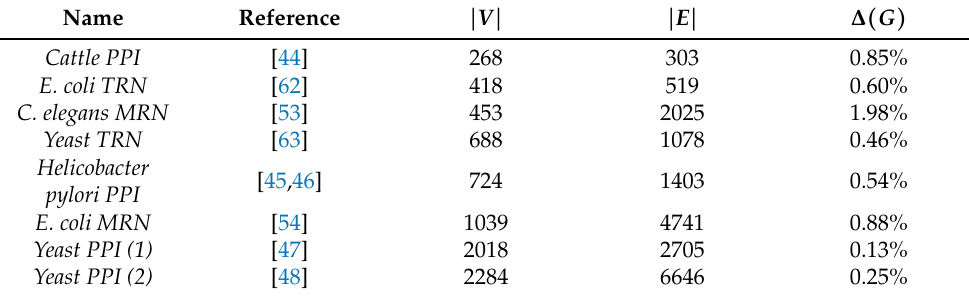
Figure 5. Convergence behavior of H YBRID -IA on E. coli MRN network. ( a ) Average and best fitness value of the population versus generations. ( b ) Information gain and standard deviation versus generations. Table 1. The biological networks used in the